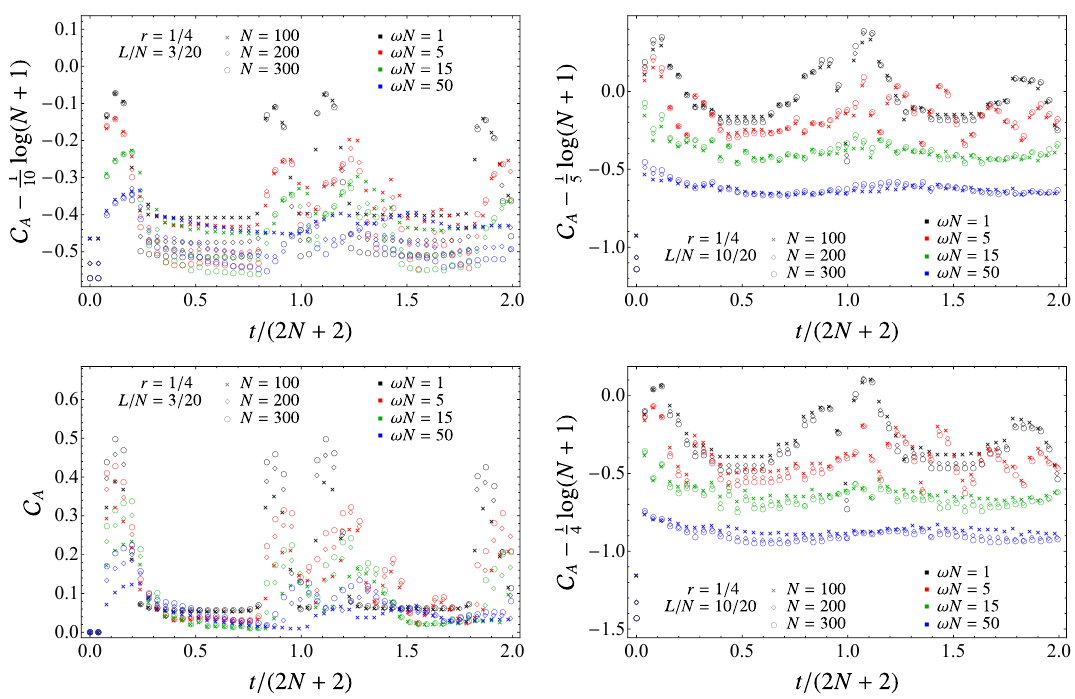
Figure 12 . Temporal evolution of the subsystem complexity C A in (4.4) for a block A made by L consecutive sites adjacent to the left boundary of harmonic chains made by N sites (see figure 1, bottom left panel) after a local quench with ω > 0 and r = 1 / 4 . The size of the blocks is fixed to a value L/N < r in the left panels and to a value L/N > r in the right